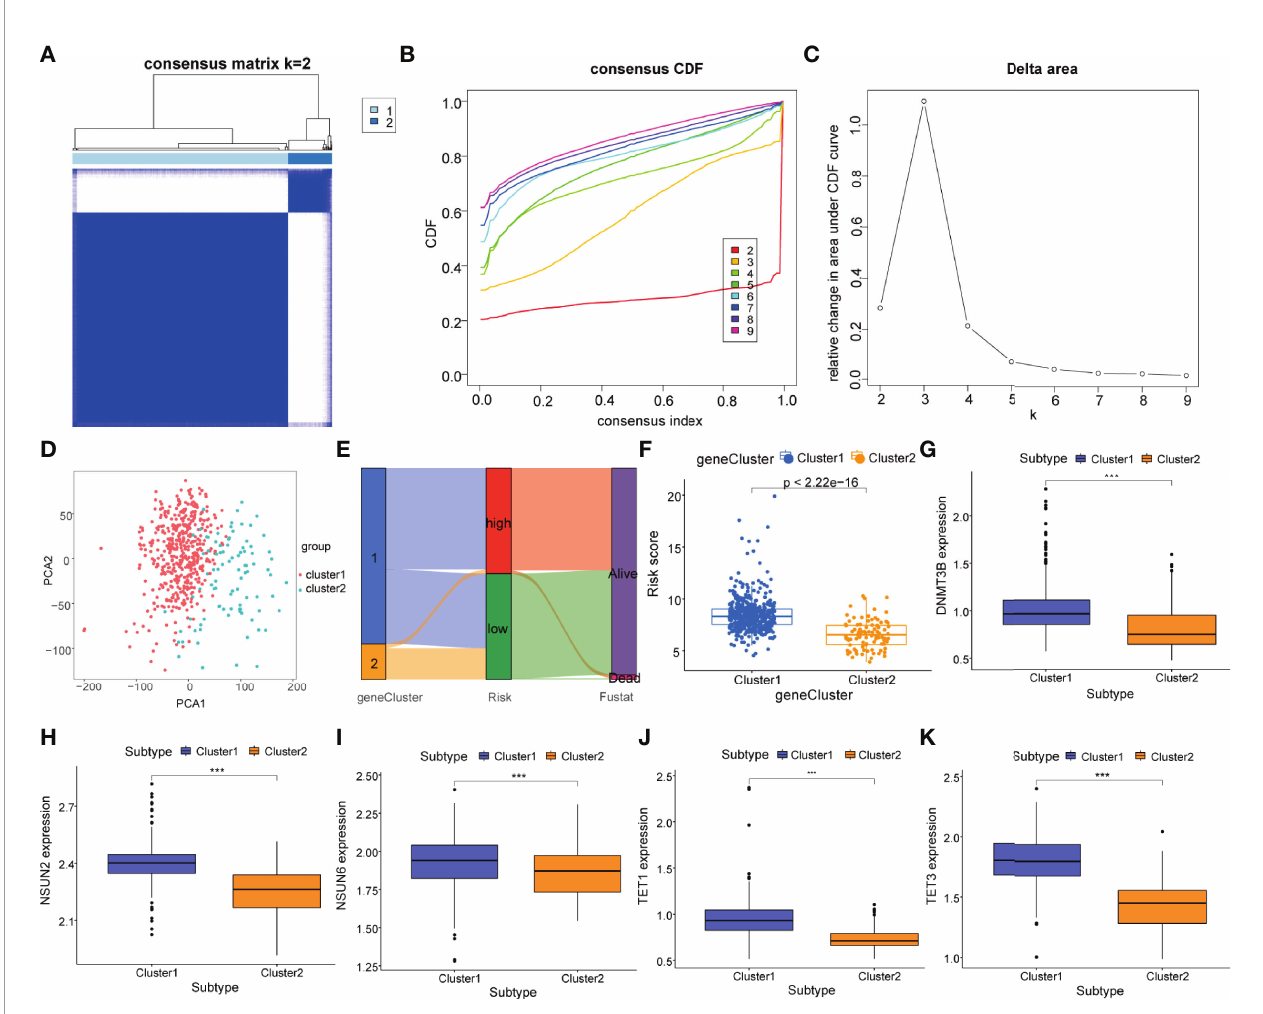
FIGURE 5 | Identi fi cation of m5C regulatory gene clusters in PCa. (A) The PCa patients were strati fi ed into 2 clusters based on the consensus clustering matrix (k = 2). (B, C) Consensus clustering model with cumulative distribution function (CDF) by k from 2 to 9. (D) The PCA analysis of the m5C regulatory gene cluster 1 and m5C regulatory gene cluster 2 based on the m5C regulatory genes. (E) Sankey diagram of subtype distributions in clusters with different risk scores and survival outcomes. (F) Differences in the risk score between the m5C regulatory gene cluster 1 (cluster 1, blue) and the m5C regulatory gene cluster 2 (cluster 2, yellow). Expression of m5C regulatory genes including (G) DNMT3B , (H) NSUN2 , (I) NSUN6 , (J) TET1 , and (K) TET3 in m5C regulatory gene cluster 1 (cluster 1, blue) and m5C regulatory gene cluster 2 (cluster 2, yellow). P -values was shown as *** P <